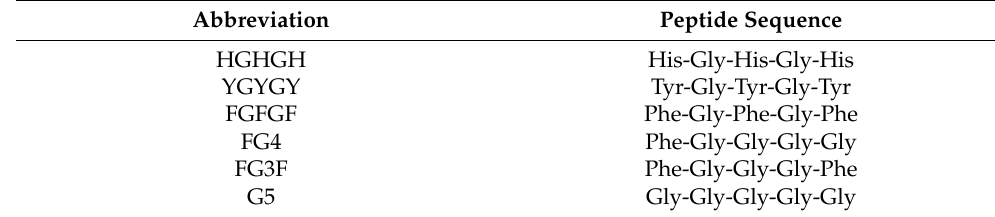
Table 1. Composition of the designed